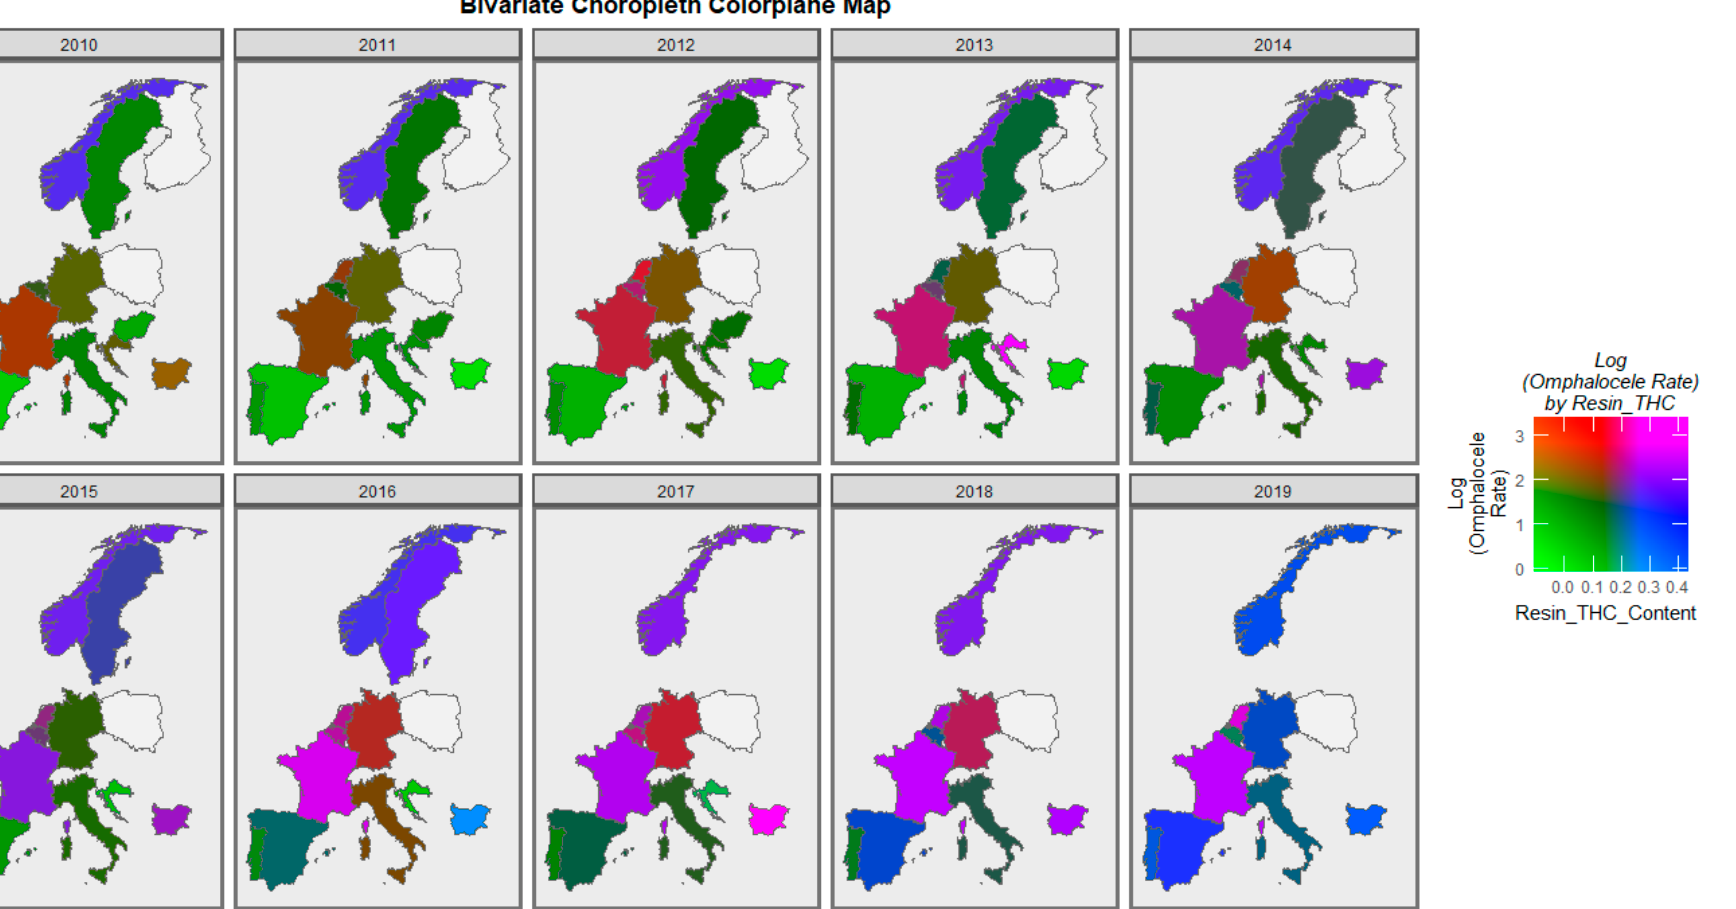
Figure 10. Bivariate colorplaner sequential map-graph of omphalocele by cannabis resin THC concentration across selected European nations for each year of 2010–2019.